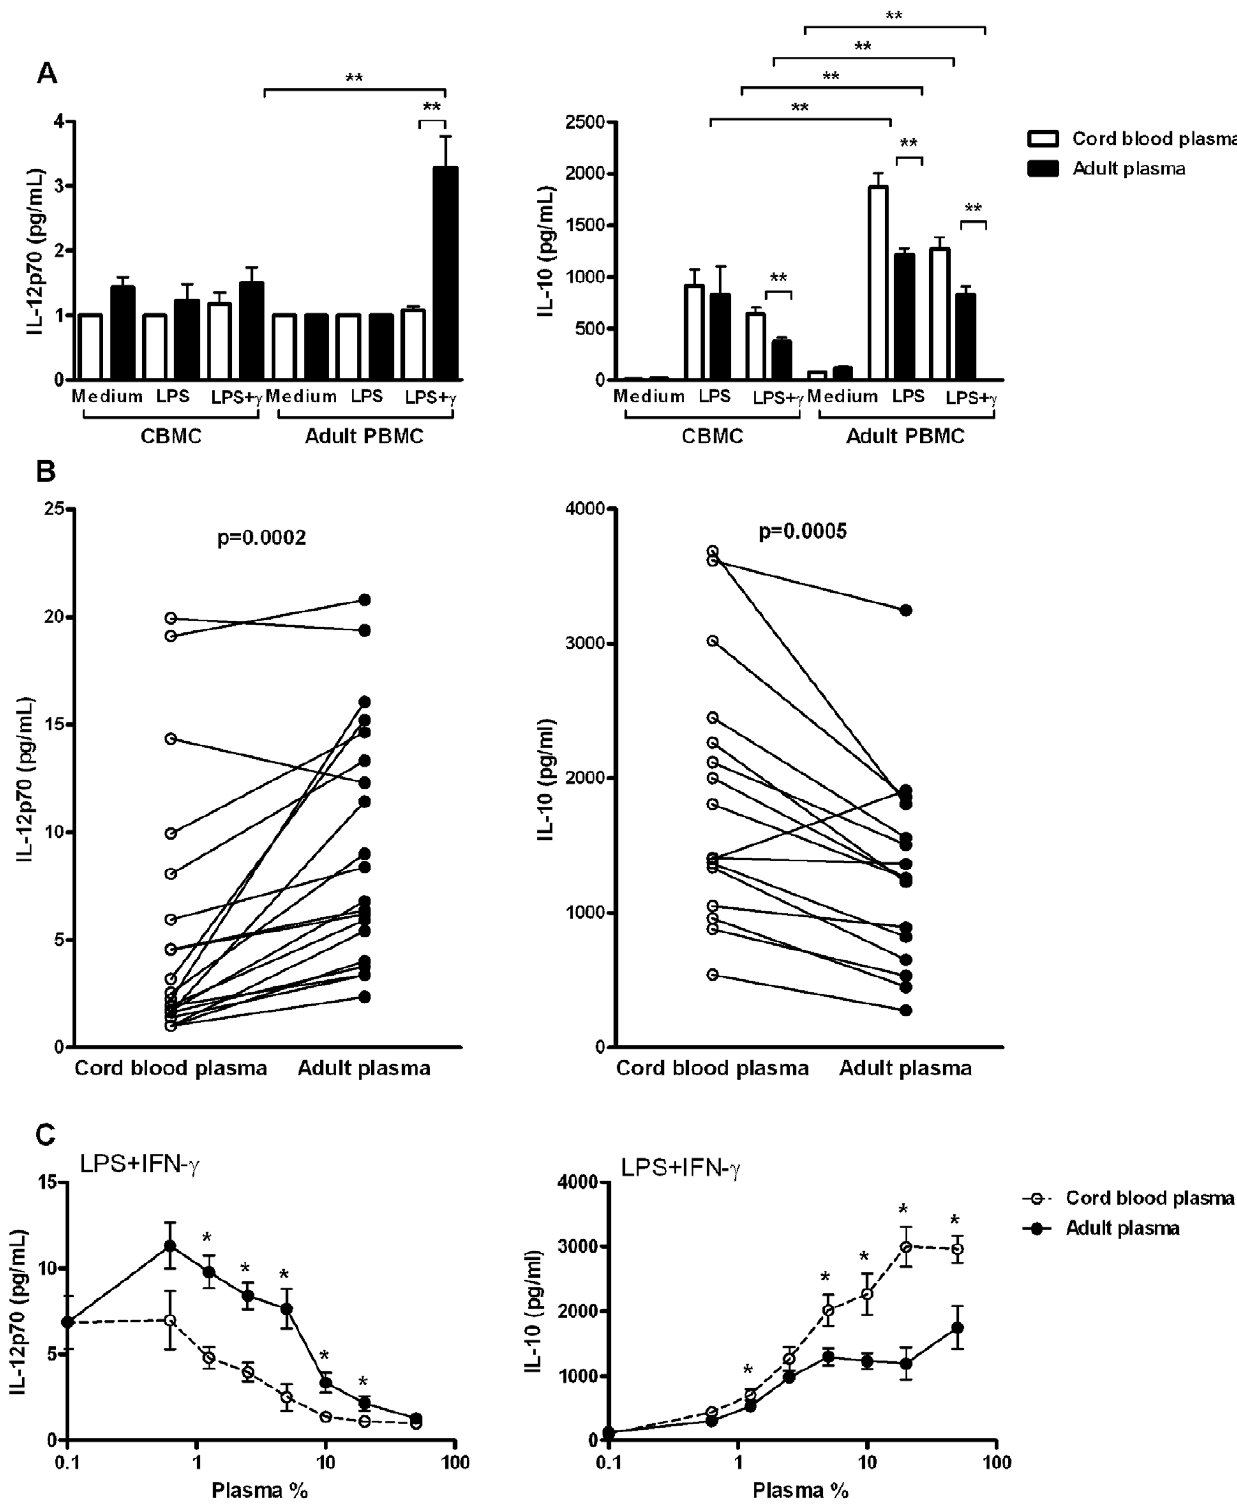
Figure 1. Human plasma suppresses TLR4-mediated production of IL-12p70 while inducing IL-10. A; TLR4-mediated release of IL-12p70 and IL-10 by cord blood mononuclear cells (CBMC) or adult peripheral blood mononuclear cells (PBMC) stimulated in the presence of 10% cord blood plasma or adult plasma. Bars represent mean + SEM of five independent cord blood or adult plasma donors. B; TLR4-mediated release of IL-12p70 and IL-10 by PBMC from three different adult donors stimulated in the presence of 10% cord blood plasma or adult plasma. C; Dose-response curves showing TLR4-mediated release of IL-12p70 and IL-10 by adult PBMC in the presence of increasing concentrations of cord blood plasma or adult plasma. Each dot represents mean 6 SEM of five independent cord blood or adult plasma donors. Data are representative of three independent experiments. *; p , 0.05, **; p , 0.01.